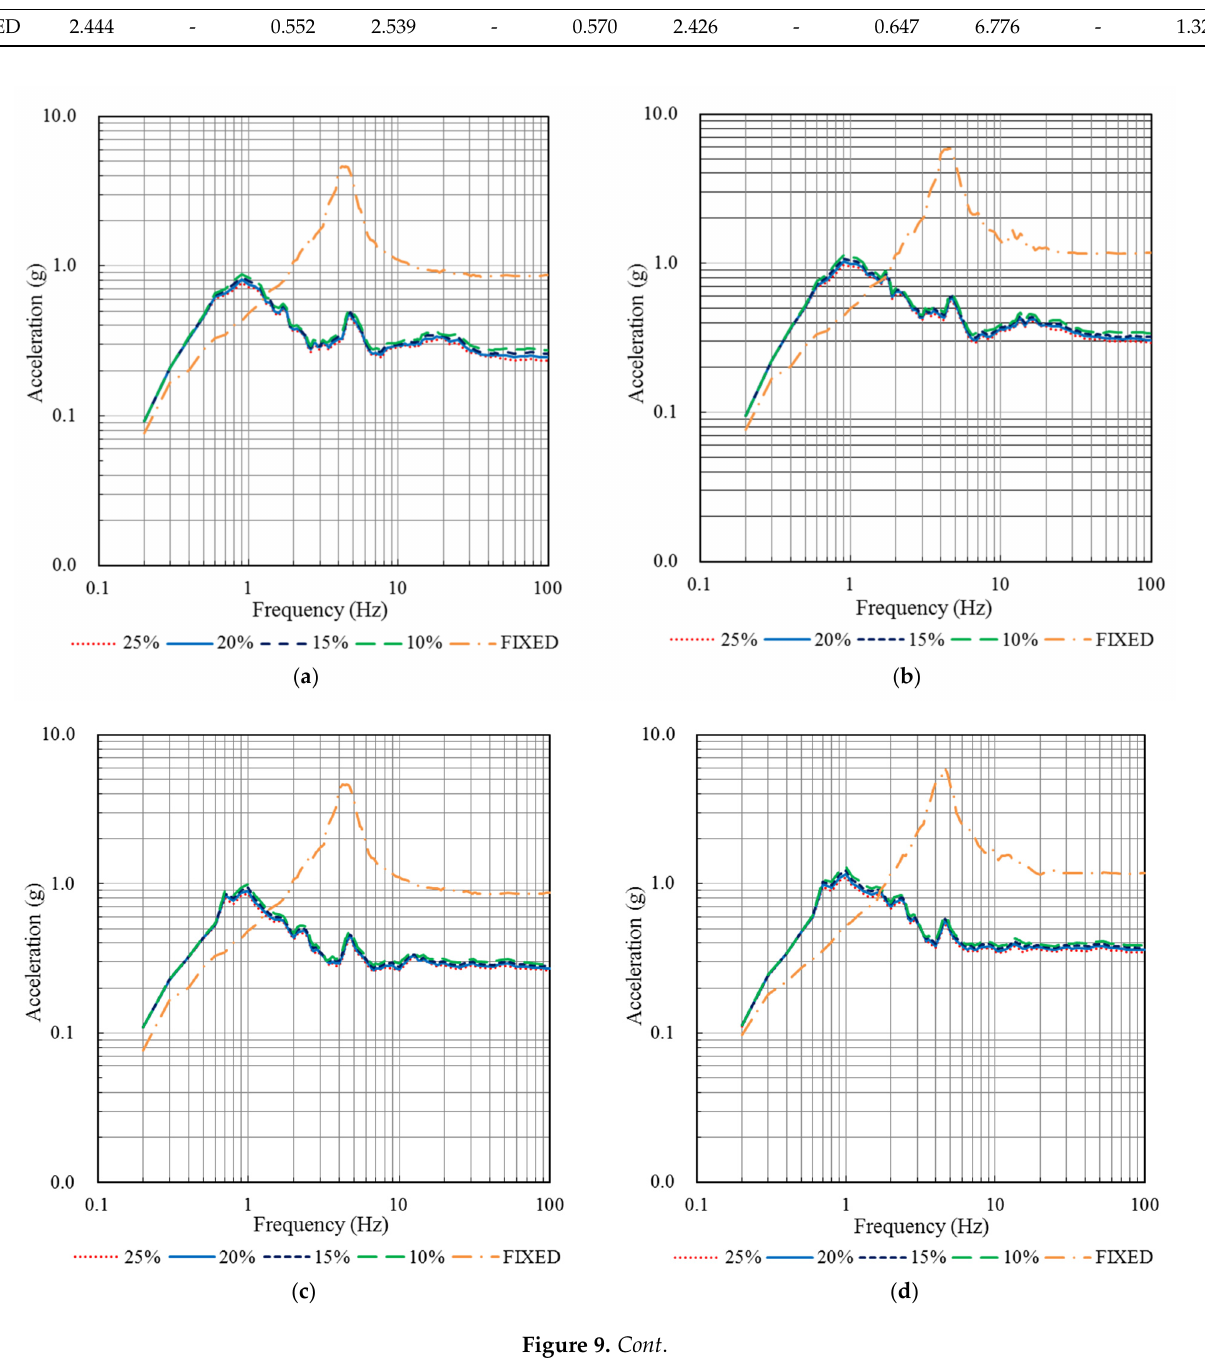
( f ) Figure 9. Comparison of the FRS of containment and internal structures in the horizontal direction. ( a ) NODE 12_X; ( b ) NODE 13_X; ( c ) NODE 12_Y; ( d ) NODE 13_Y; ( e ) NODE 3_X; ( f ) NODE 4_X. Table 3. Comparison of peak values and ZPA of the FRS in the horizontal direction. TYPE